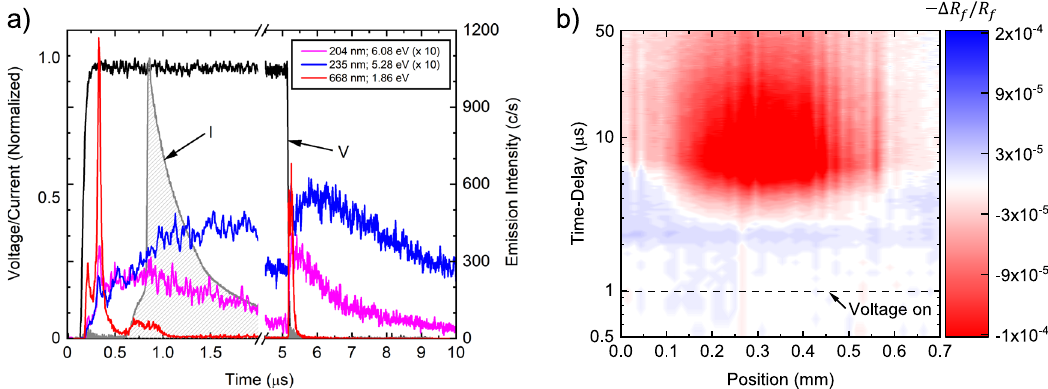
Fig. 3 Time-resolved emission and in-plane thermal transport dynamics. a Time-resolved emission measurement of the He jet interacting with the gold surface along with the voltage applied to the electrode and the measured surface current. The emission lines shown are from He * at 668 nm and NO * at 204 nm and 235 nm, illustrating that a range of energetic photons arrives at the surface both before and after the charged particle fl ux. b Spatially-resolved thermore fl ectance measurements of an Au surface. A width of 0.5 mm is heated from the fl ux of charged particles, while the observed photon-induced cooling extends to a much larger region. Blue corresponds to the observed cooling of the sample surface (increase in the modulated re fl ectance signal, Δ R Δ R f ), while red denotes an increase in surface temperature (decrease in f